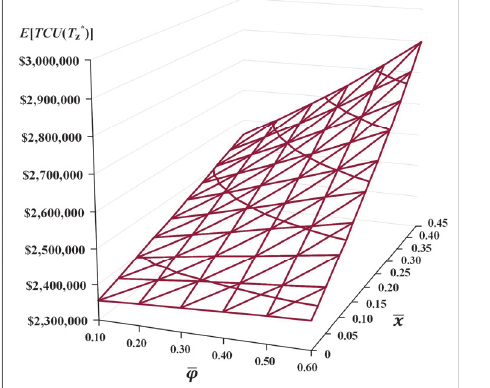
Fig. 16. The variations of t i * concerning the collective impact of α 1, i and 